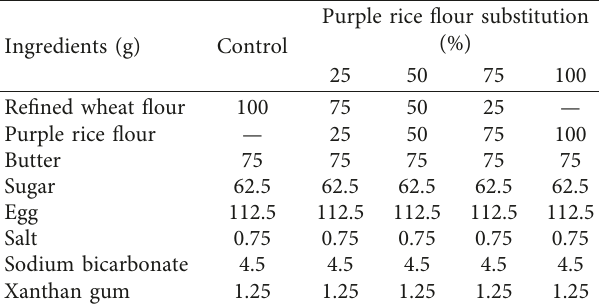
Table 1: Formulation of biscuits supplemented with purple rice